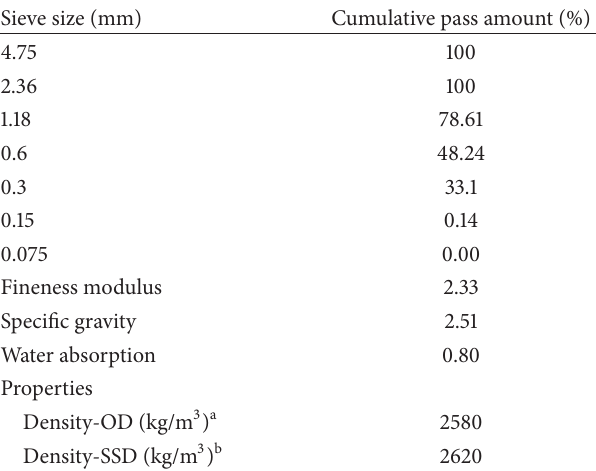
Table 2: The particle size distributions and physical properties of fine